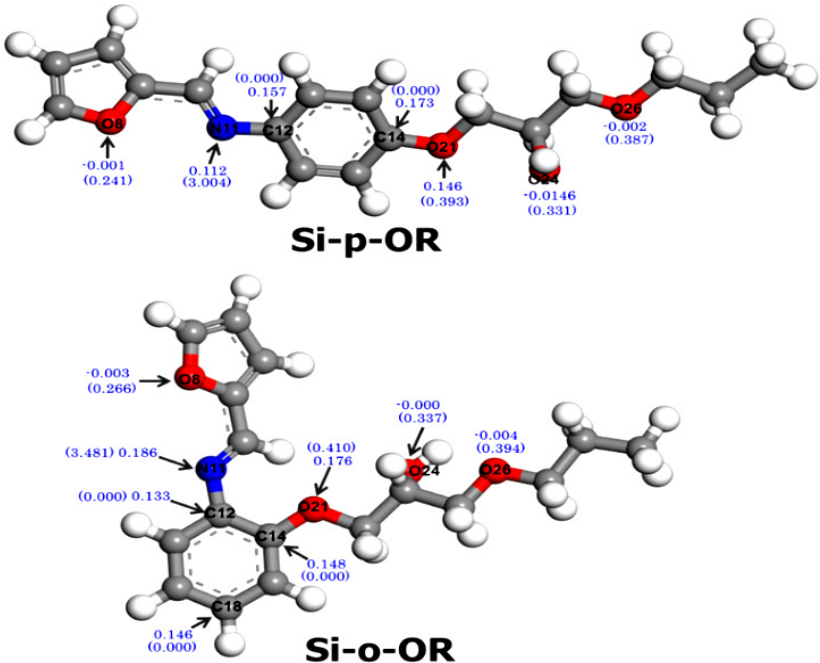
Figure 13. Optimized structures and P-values of significant atoms of Schiff bases. NBED values are given between parentheses.